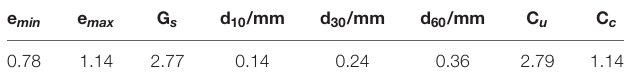
TABLE 1 | Basic physical parameters of